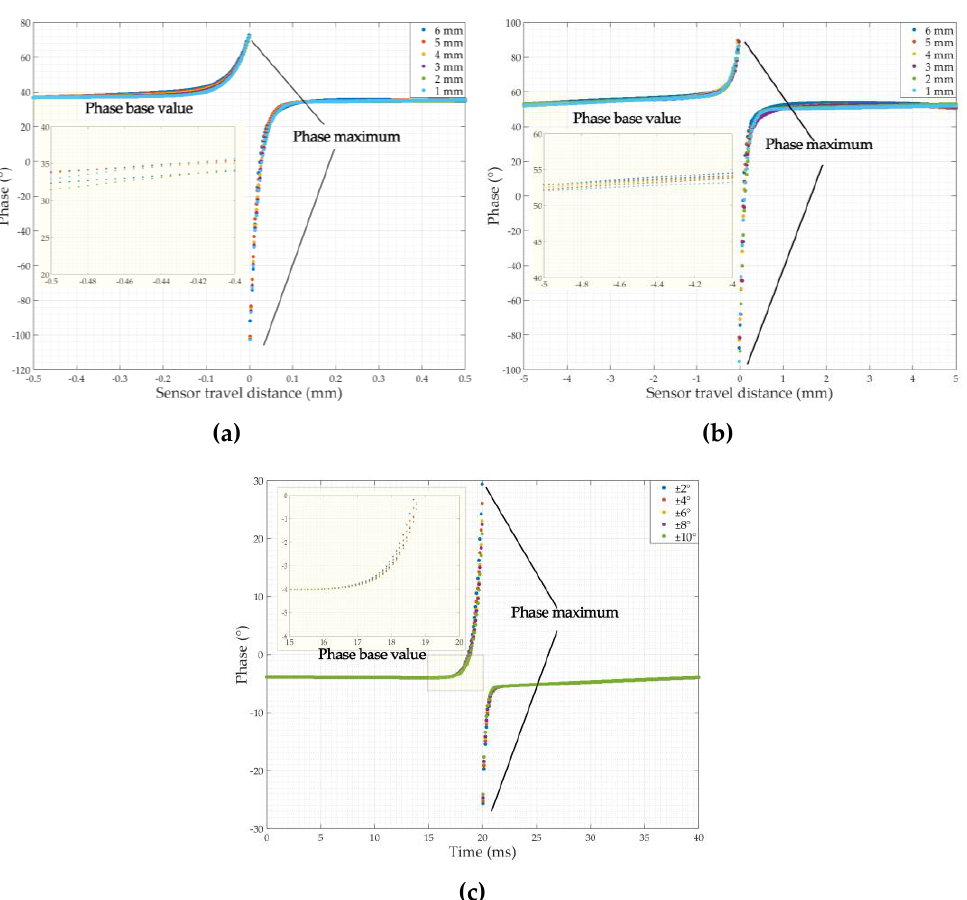
Figure 8. The phase of the simulation signals: ( a ) The phase of the circumferential crack detection signals; ( b ) The phase of the axial crack detection signals; ( c ) The phase of the jitter signals.